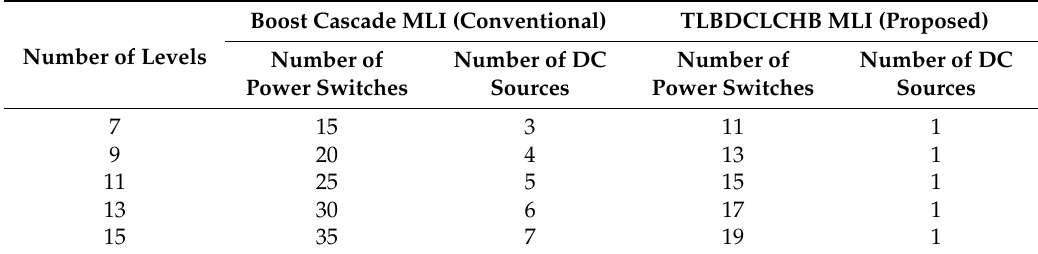
Table 1. Component requirements for existing and proposed boost based MLI systems.